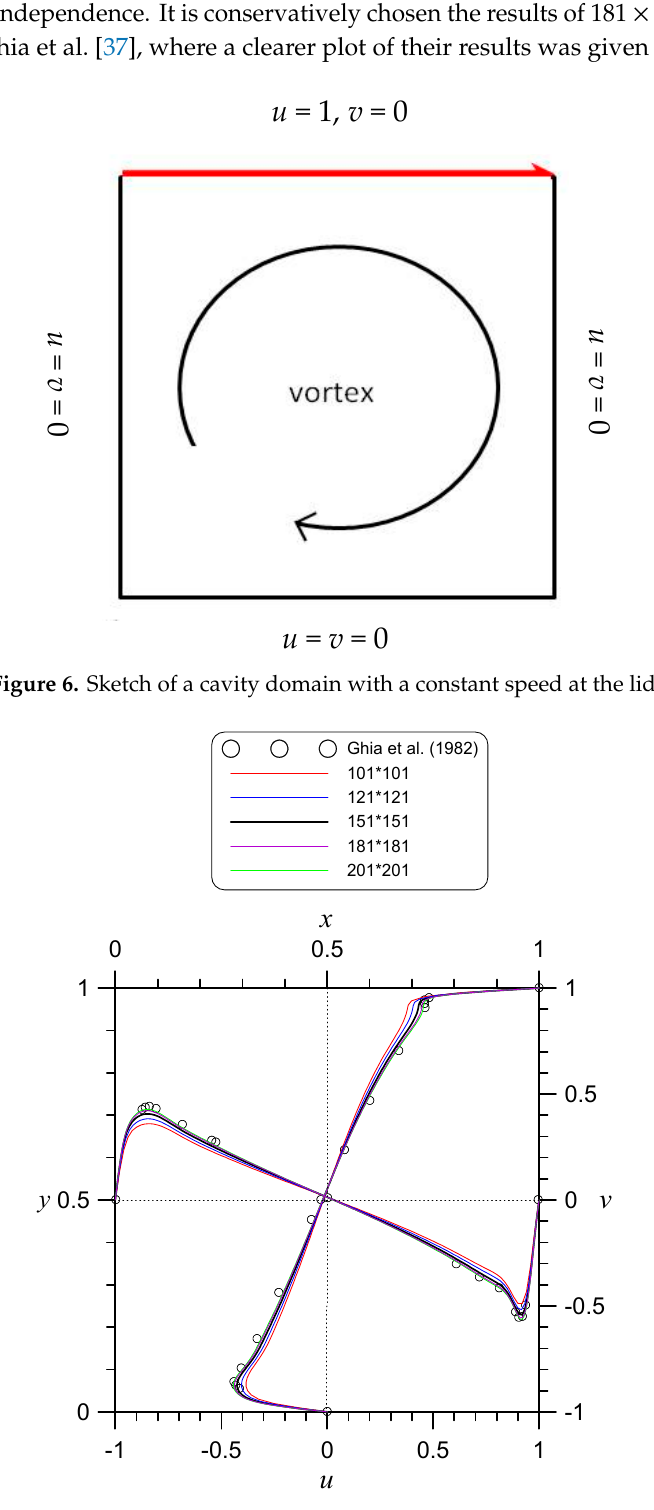
Figure 7. Computed steady velocity profiles for Re